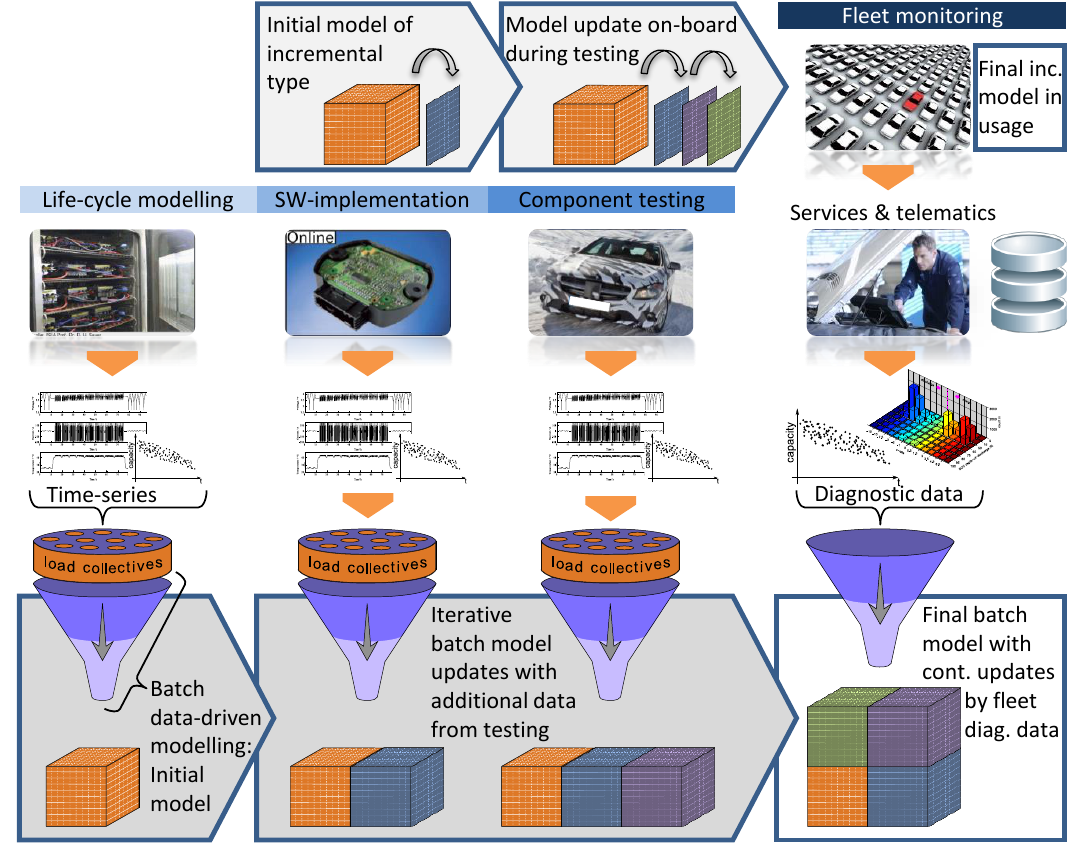
Figure 9. Model usage on-board and by a fleet management system respectively, for health monitoring and degradation prognosis of lithium-ion